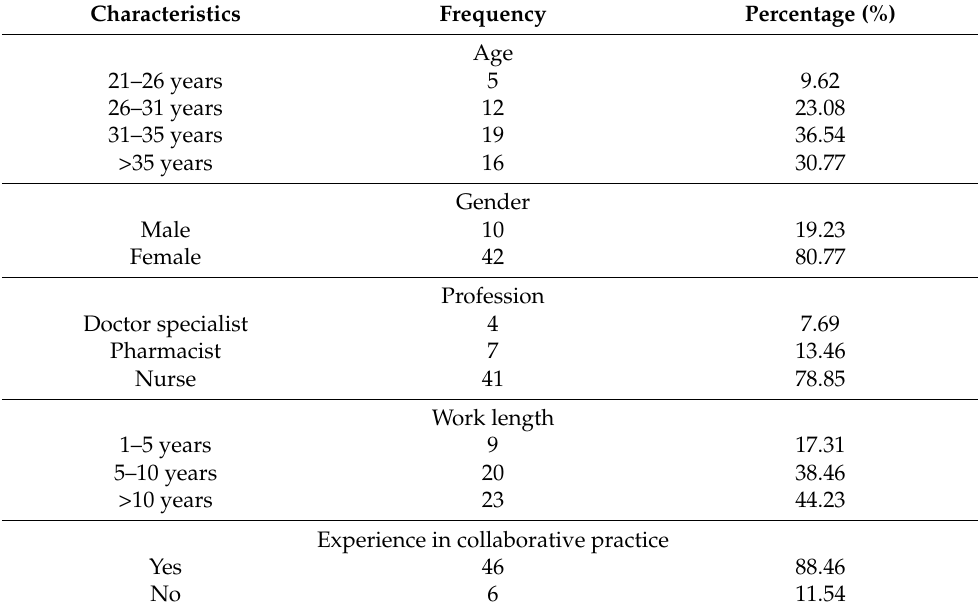
Table 4. CPAT respondent demography characteristic for Study II (N HUH = 52).